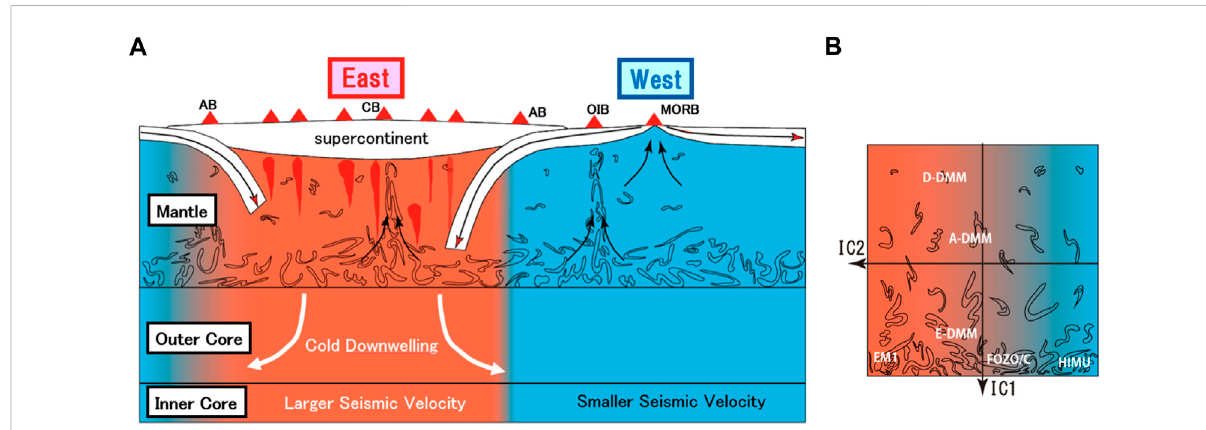
FIGURE 6 Model of top-down hemispherical dynamics and material recycling with two overlapping differentiation processes and focused subduction beneaththesupercontinent(IwamoriandNakamura,2015). (A) :Irregularstreaksrepresentrecycling ‘ meltcomponent ’ ,whichareaccumulated near CMB, resulting in IC1 variations mostly in the vertical direction. These streaks then ascend due to thermal instability to form OIB. Two large plumes may constitute a degree-2 structure at the deep mantle. At the same time a hemispherical degree-1 structure can coexist: The horizontally divided red and blue regions represent a hemisphere enriched in ‘ hydrophile component ’ (positive IC2) beneath the supercontinent and another depleted hemisphere (negative IC2) beneath the ocean, respectively. The former is colder than the latter, due to focused subduction (see the main text for more details). Rising plumes (shown as dark red plumes) beneath the supercontinent represent fl uid component-assisted plumes. AB=arc basalt, CB=continental basalt. (B) : the conventional mantle geochemical end-members (DMMs, EM1, EM2, HIMU, FOZO/C; see the main text for explanation) are expressed by the combination of IC1 and